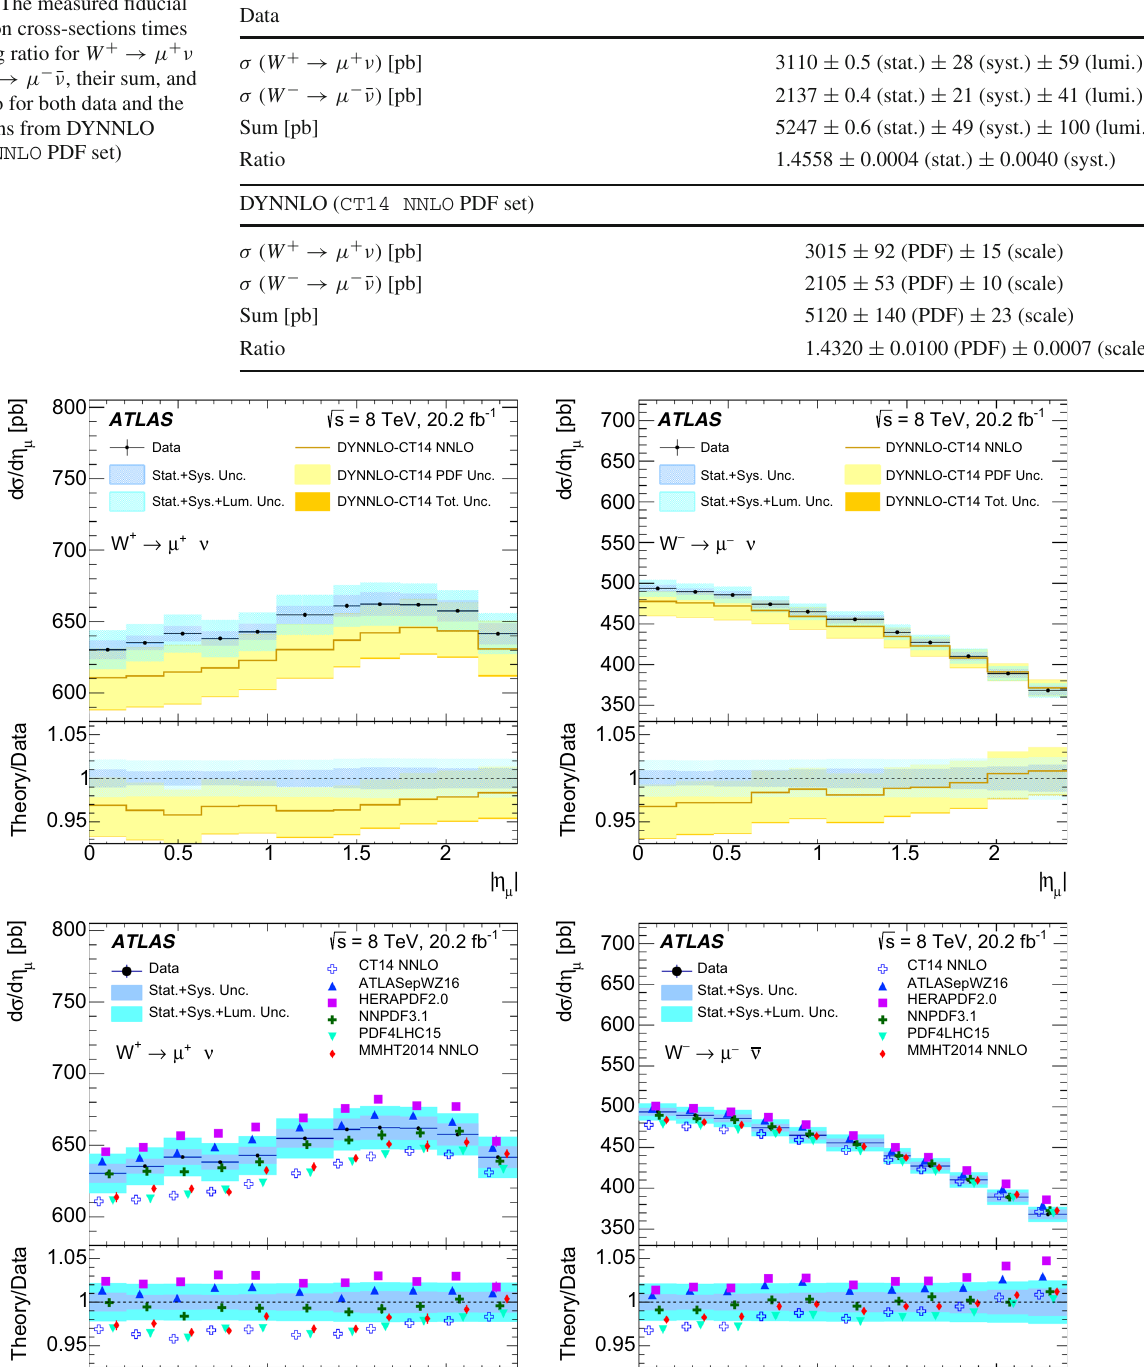
Fig. 4 The W + (left) and W − (right) fiducial cross-sections, differ- ential in muon pseudorapidity multiplied by the branching fraction for the decay into a muon and a neutrino are shown as a function of the absolute muon pseudorapidity. The data are presented with systematic and total uncertainties (the data statistical uncertainties are smaller than the size of the markers) and are compared with the predictions from